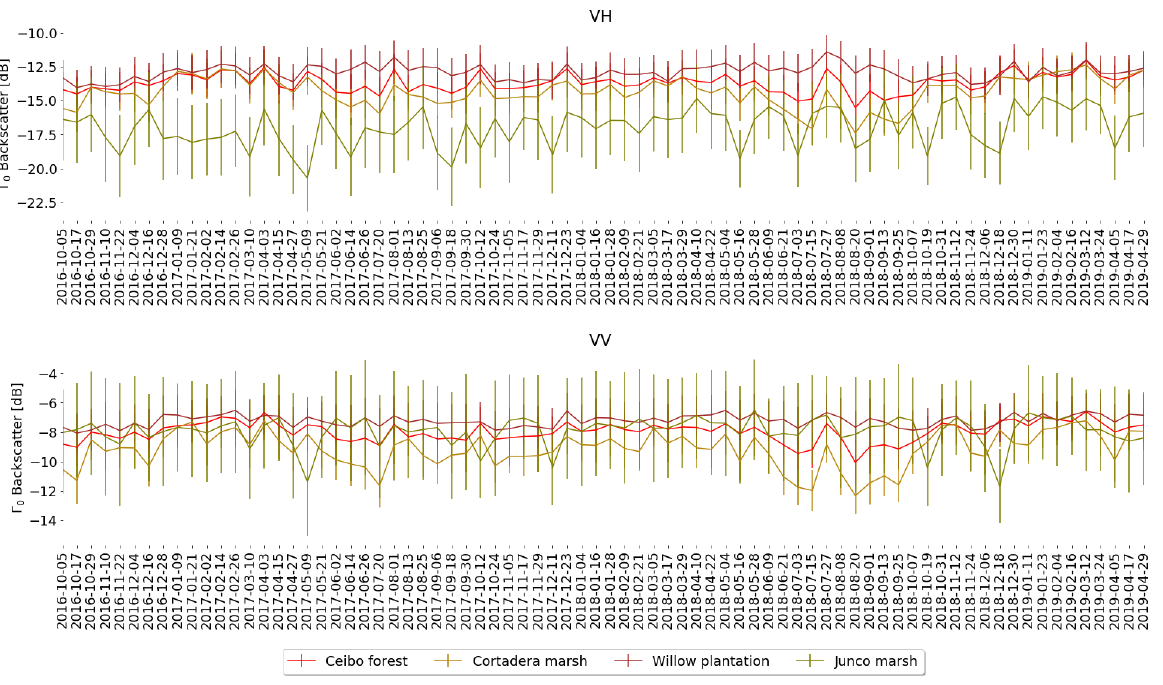
Figure 2. Multitemporal signature of Sentinel-1 gamma 0 values for the reference data vegetation classes of the Lower Delta of the Paran´a River. The values are computed as averages of the reference data for each class, and the error bars represent the standard variation of the backscatter value for each